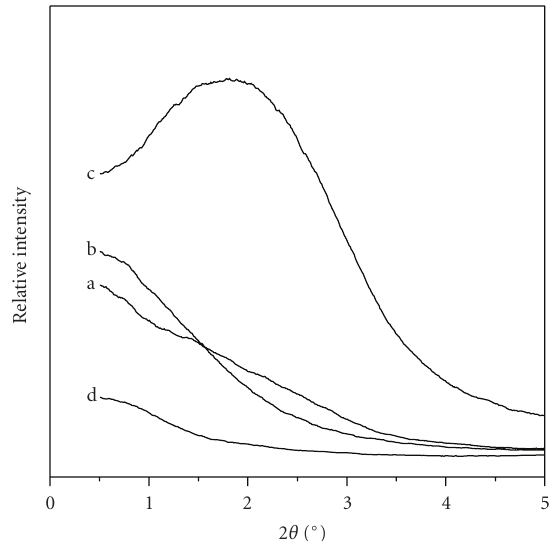
Figure 4: Low-angle powder XRD patterns of mesoporous Au/TiO 2 samples synthesized by hydrothermal route and calcined at di ff erent temperatures: (a) H1, (b) H2, (c) H3, and (d) H4.